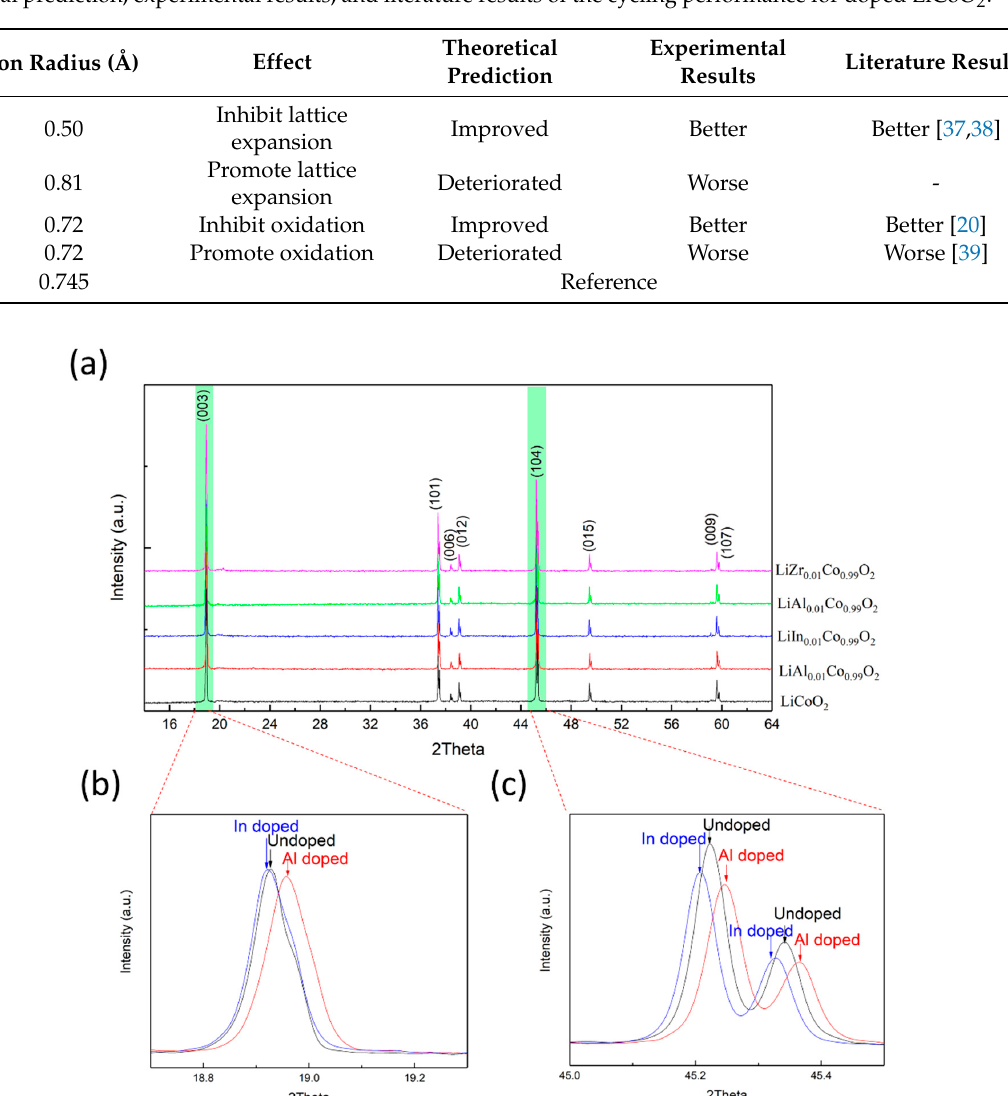
Figure 6. ( a ) XRD patterns of doped and undoped LiCoO 2 . ( b ) Enlarged view of (003) peak. ( c ) Enlarged view of (104) peak. Table 2. Calculated lattice parameters of doped LiCoO 2 , and their variation compared to the un- doped LiCoO 2 .